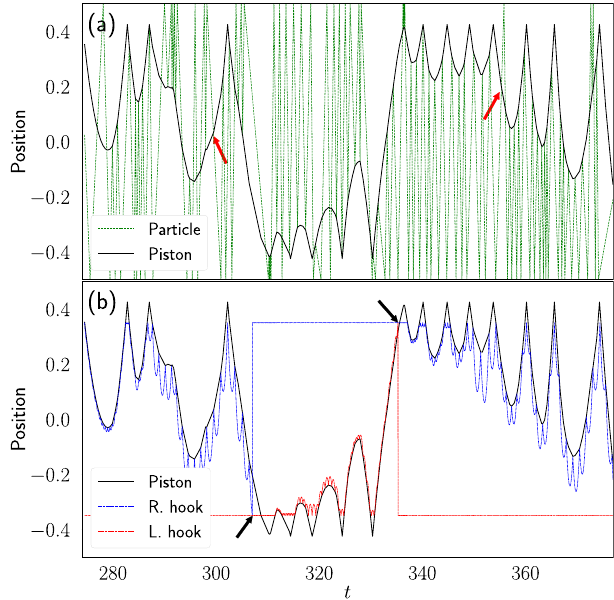
Figure 2. Example of the system dynamics. ( a ) Position along the container of the particle and the piston as a function of time. ( b ) Position of the piston, left and right hooks as a function of time, during a simulation of the engine where p = 0.2 and M l = 1.0 . The arrows in ( a ) point to some events where the particle crosses through the pore, while the arrows in ( b ) point to events where one of the hooks is pushed out of the system and